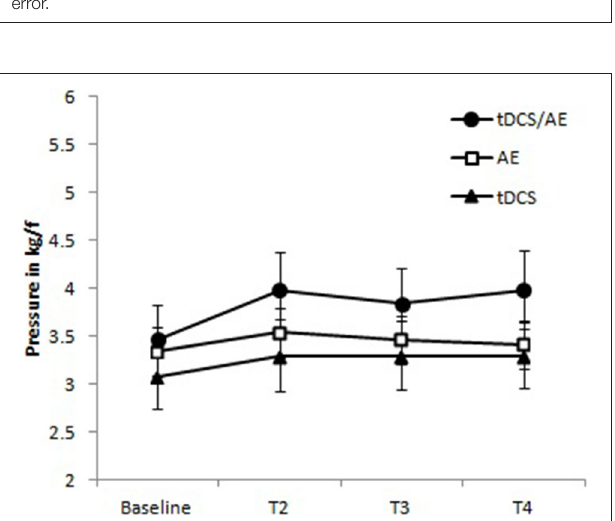
FIGURE 5 | Response for level of anxiety (VNS anxiety). T1, assessment after the fifth day of intervention; T2, assessment after 1 month of intervention; T3, assessment after 1 month of the end of the intervention (follow-up 1); T4, assessment after 2 months of the end of the intervention (follow-up 2). Paired evaluation between groups p < 0.001. Data presented as mean and standard error.